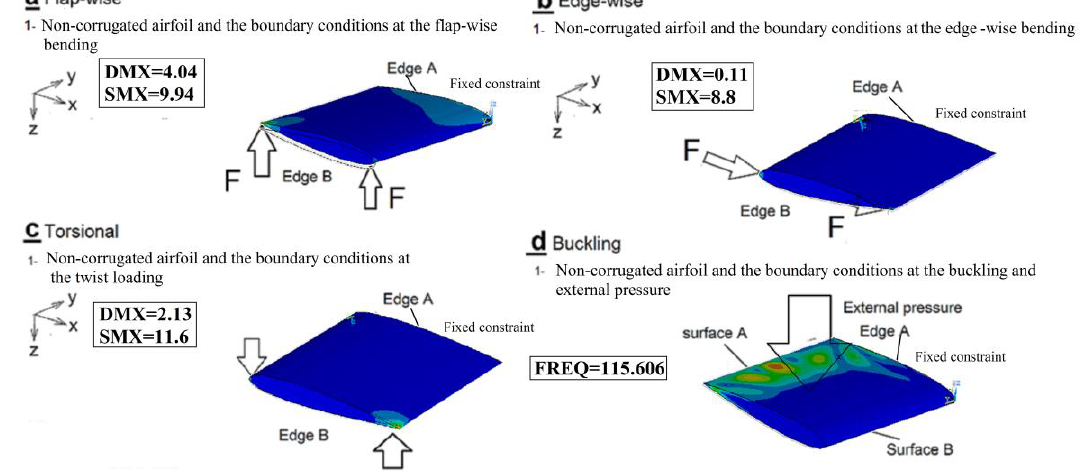
Figure 5. The applied boundary conditions and the FE simulation of NACA0012. ( a ) Flap-wise, ( b ) edge-wise, ( c ) torsional, ( d )buckling.